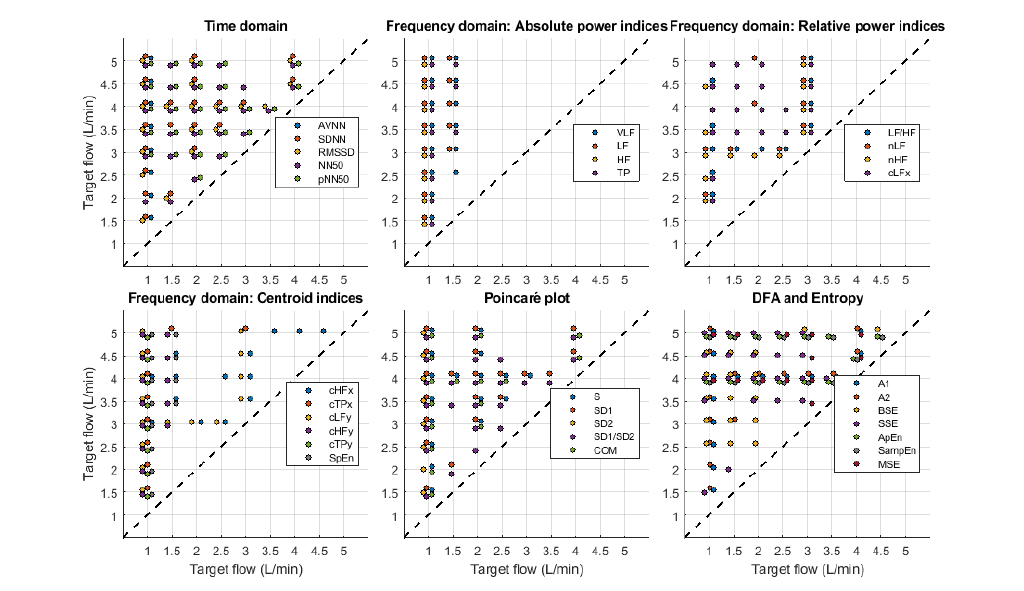
Figure 10. Post-hoc comparisons for target flow (TF) levels when pulse rate variability indices are measured from the deep palmar arch phantom. The appearance of a circle indicates a significant difference between the corresponding levels for each of the